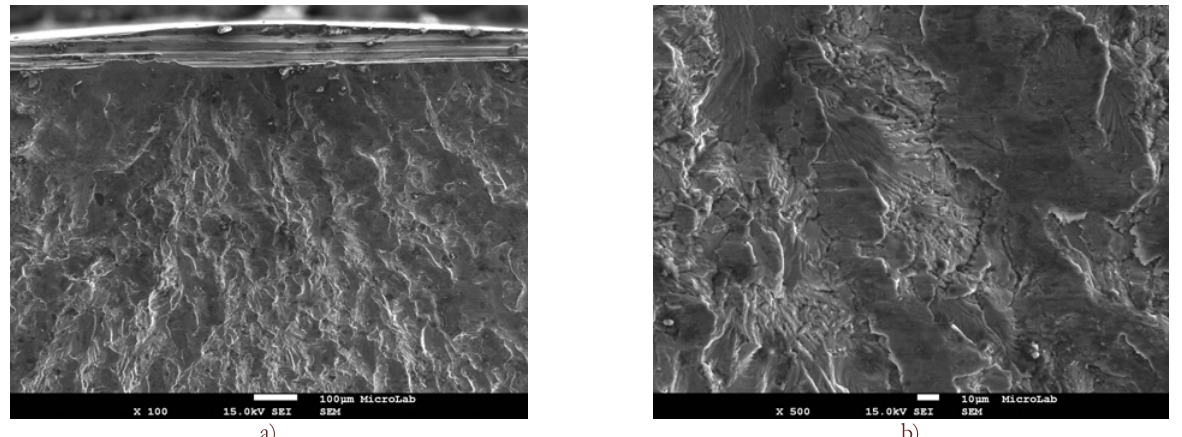
Figure 8: SEM micrographs Bs=152 MPa_Ts=71; a) initial crack growth b) crack growth